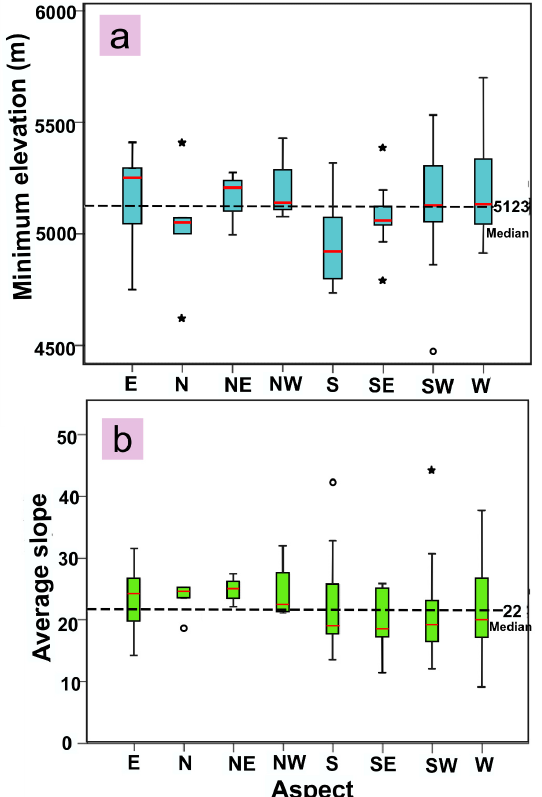
Figure 8. Box-whisker graphs plotted on the different aspects; ( a ) glaciers minimum elevations and ( b ) average slope of glaciers. Star mark in both graphs signify extreme values.